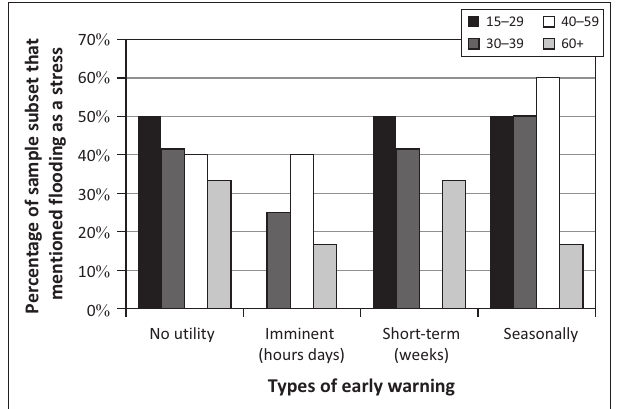
FIGURE 9: Types of desired early warning in Kasaya by